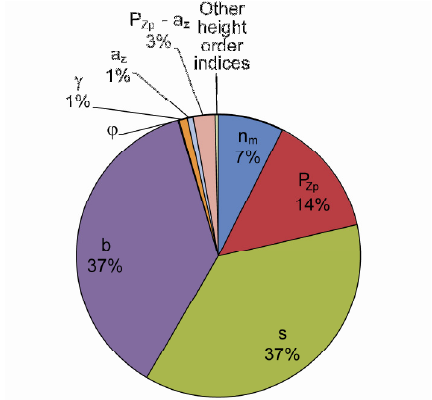
Fig. 19. Results for the third terrace ( P p is a non-random variable)